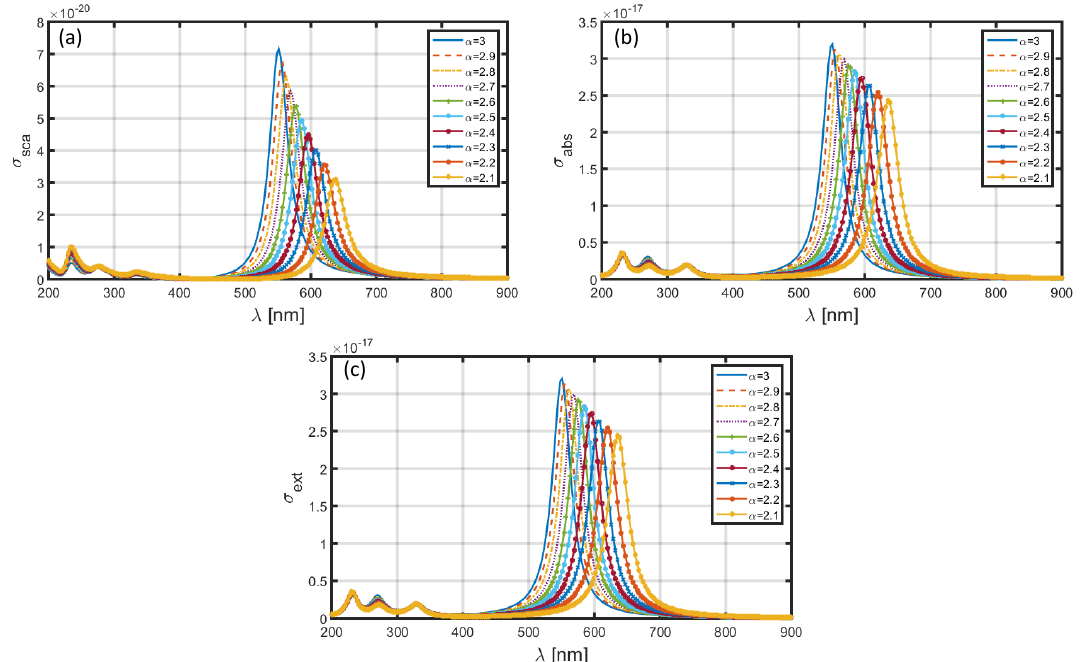
Figure 10. Plots of ( a ) scattering cross-section, ( b ) absorption cross-section, and ( c ) extinction coe ffi cient against λ for SiO 2 -Ag nanoparticle in the FD space corresponding to the dimensions a = 1.6 nm, b = 2 nm.